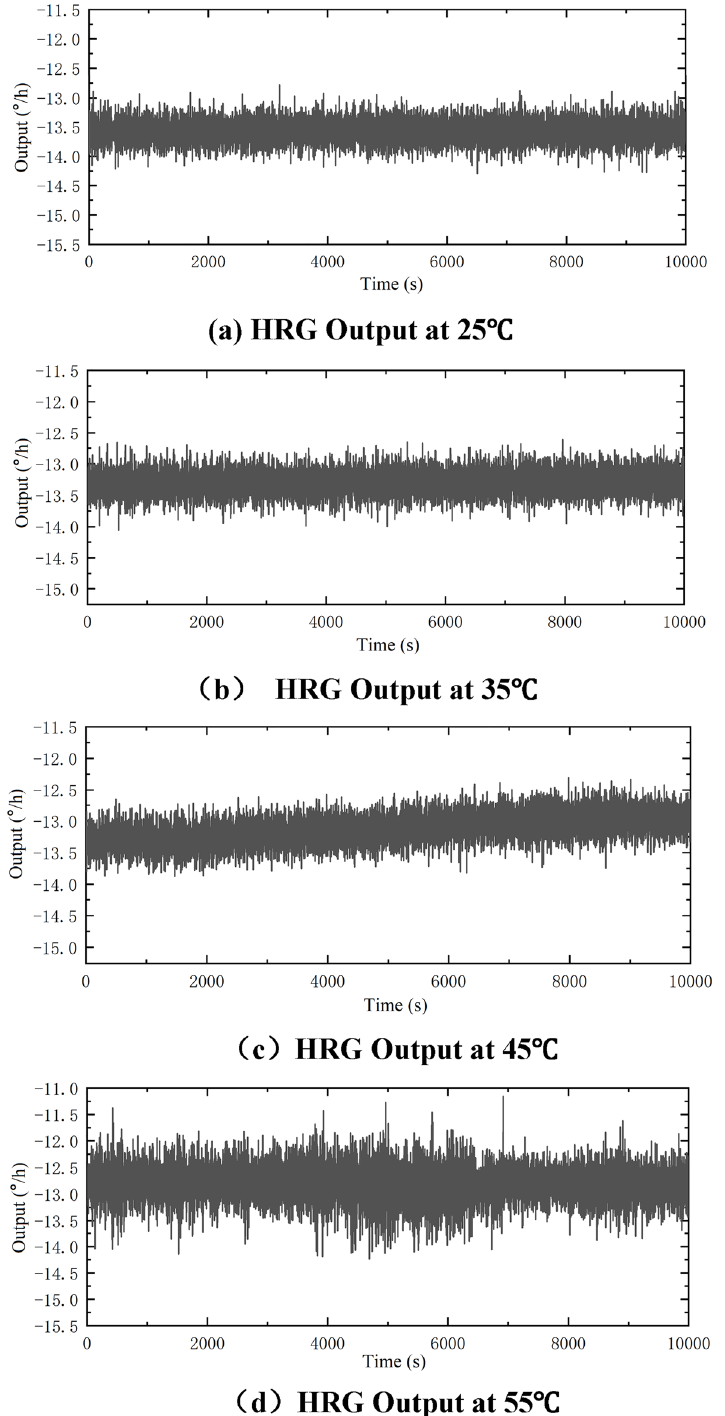
Figure 3. HRG output under constant temperature.